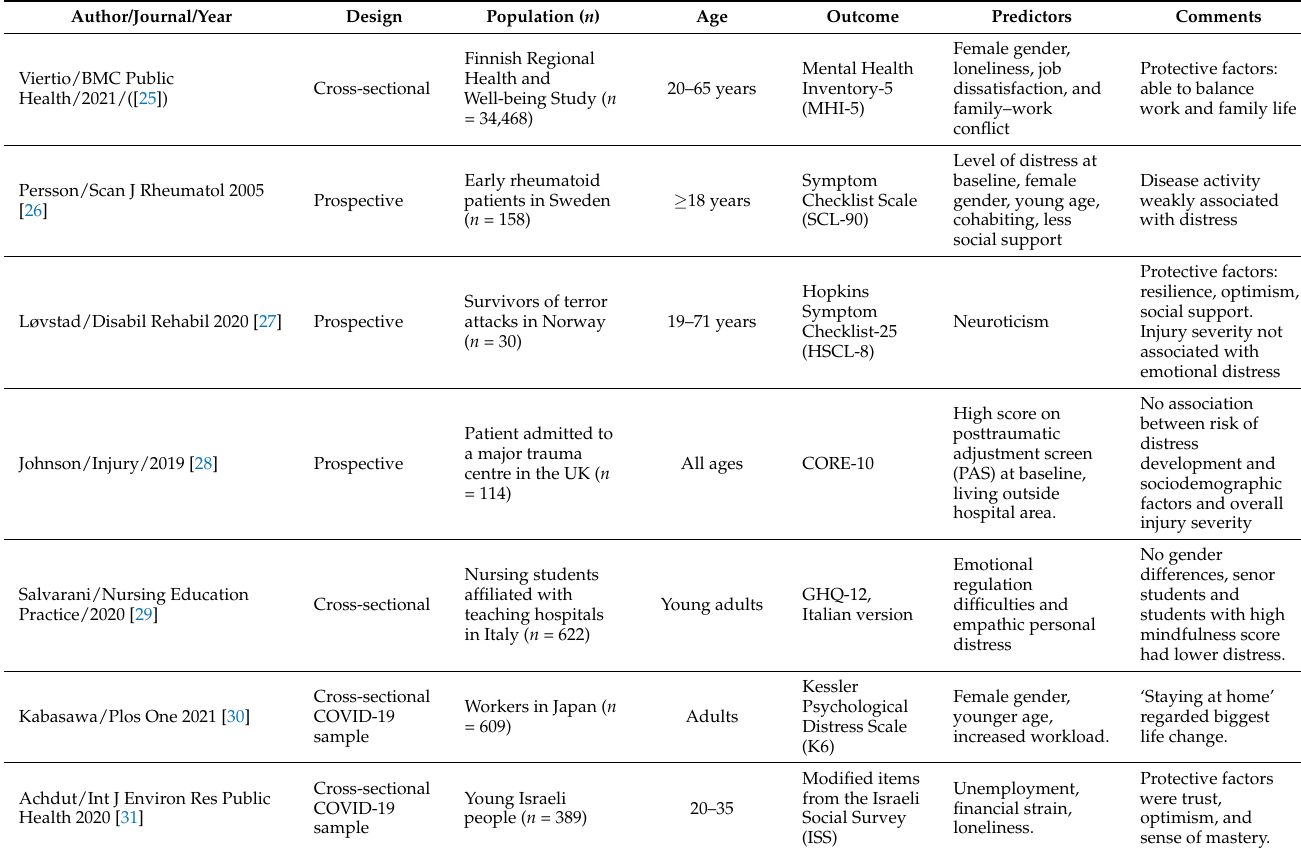
Table 4. Pre-pandemic and pandemic studies on emotional distress and associated